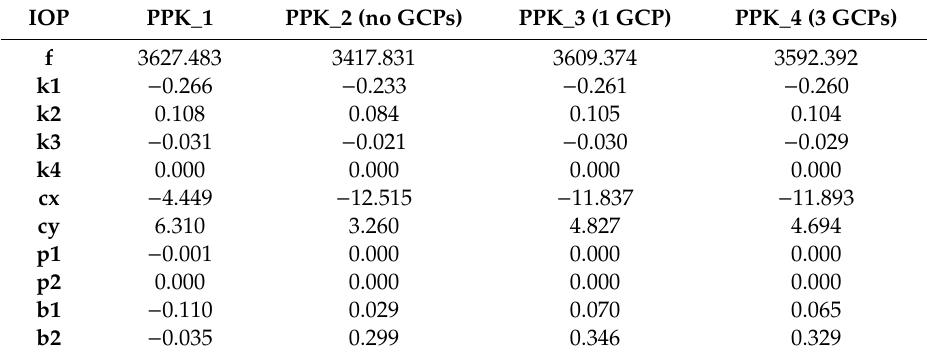
Table 11. IOP estimated through the self-calibration approach for di ff erent PPK configurations. IOP PPK_1 PPK_2 (no GCPs) PPK_3 (1 GCP) PPK_4 (3 GCPs) f